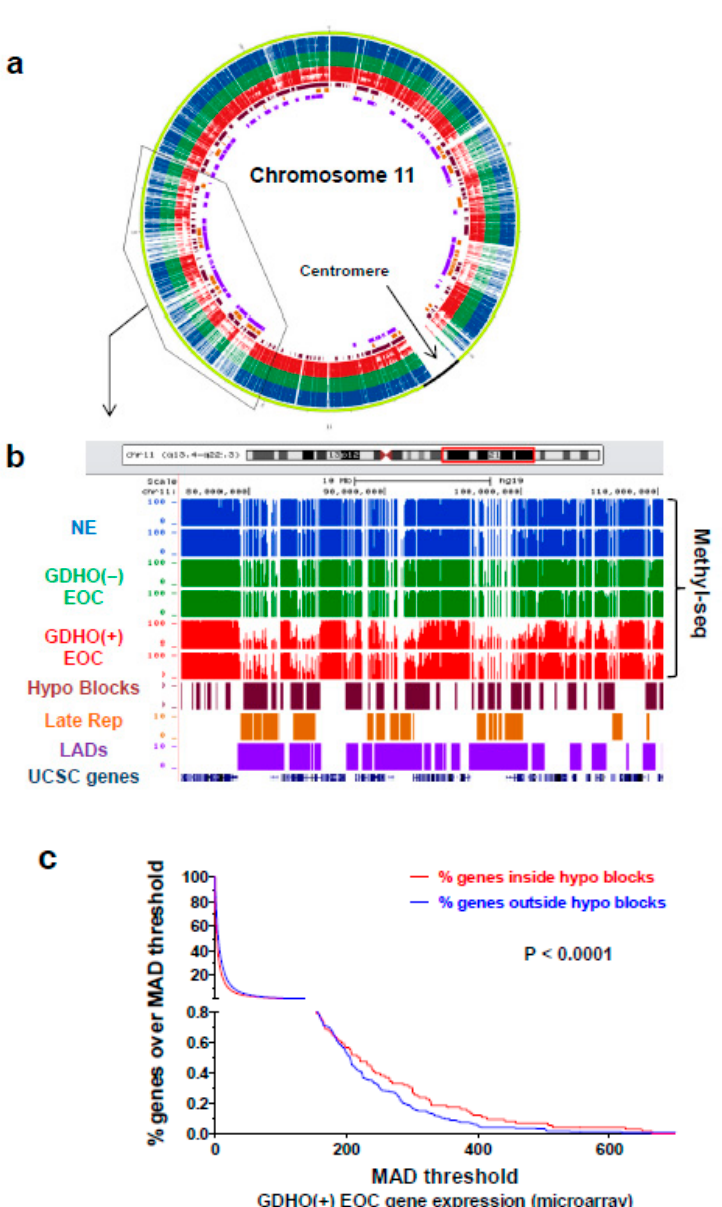
Figure 6. GDHO ( + ) EOC is characterized by hypomethylated genomic blocks. ( a ) Circos plot [60] of Methyl-seq data of chromosome 11 for OSE, FTE, GDHO ( + ) EOC, and GDHO (–) EOC. Methyl-seq data for each sample group, hypomethylated blocks, late-replicating regions, and LADs are indicated (see panel b for key). The enclosed region of the circos plot is enlarged in panel b . Chromosome 11 data is shown as an example. ( b ) Methyl-seq data for a selected region of chromosome 11 for OSE, FTE, GDHO (+) EOC, and GDHO (–) EOC. Calculated hypomethylated block regions are indicated at bottom, along with UCSC genome browser view of lamina-associated domains (LADs), late-replicating (Late rep) regions and gene positions. The Methyl-seq data is plotted on a scale from 0–100% methylation. ( c ) The relationship between hypomethylated blocks and gene expression variability in GDHO ( + ) EOC. Gene expression variability at hypomethylated blocks and non-block regions was determined using Affymetrix microarray data, by calculating the median average deviation (MAD) for individual gene expression values among the 20 GDHO (+) EOC samples. Hypomethylated blocks were calculated from Methyl-seq data by comparing GDHO (+) EOC to normal epithelia (NE; FTE + OSE average value). The 2-tailed paired t-test p-value is shown. The results indicate enrichment of hypervariable gene expression inside hypomethylated